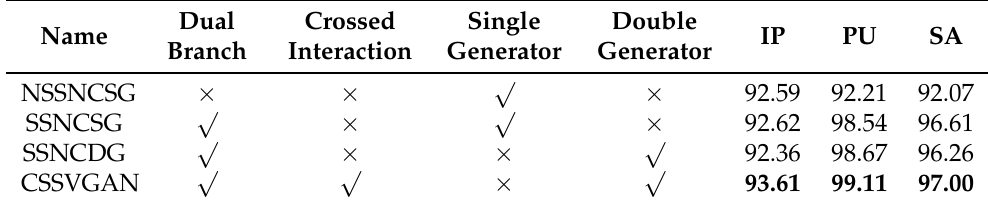
Figure 13. The frameworks of ablation experiments: ( a ) NSSNCSG ( b ) SSNCSG ( c ) SSNCDG ( d ) CSSVGAN. Table 12. The OA(%) of Ablation